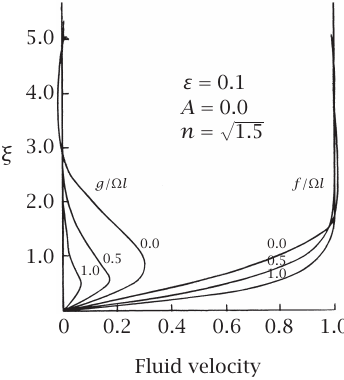
Figure 3.1 . Variations of f/ Ω l and g/ Ω l for different values of suction pa- rameter S in absence of variable suction A .